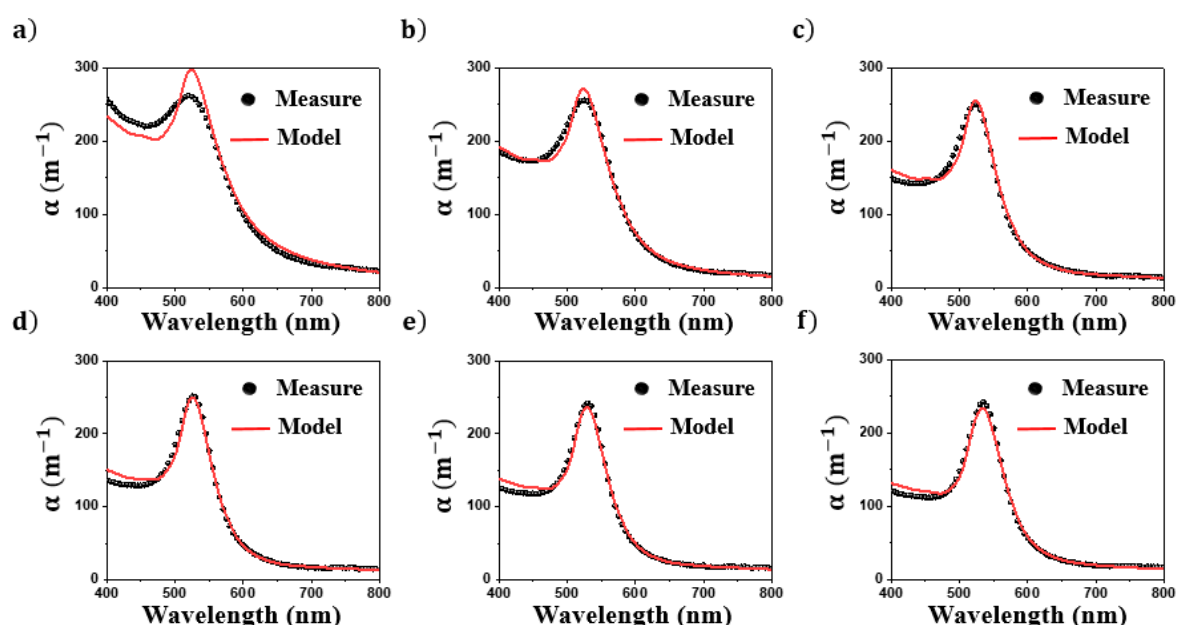
Figure 6. Comparison between the measured and modeled extinction spectra of ( a ) S1, ( b ) S2, ( c ) S3, ( d ) S4, ( e ) S5, and ( f ) S6 Au colloids.